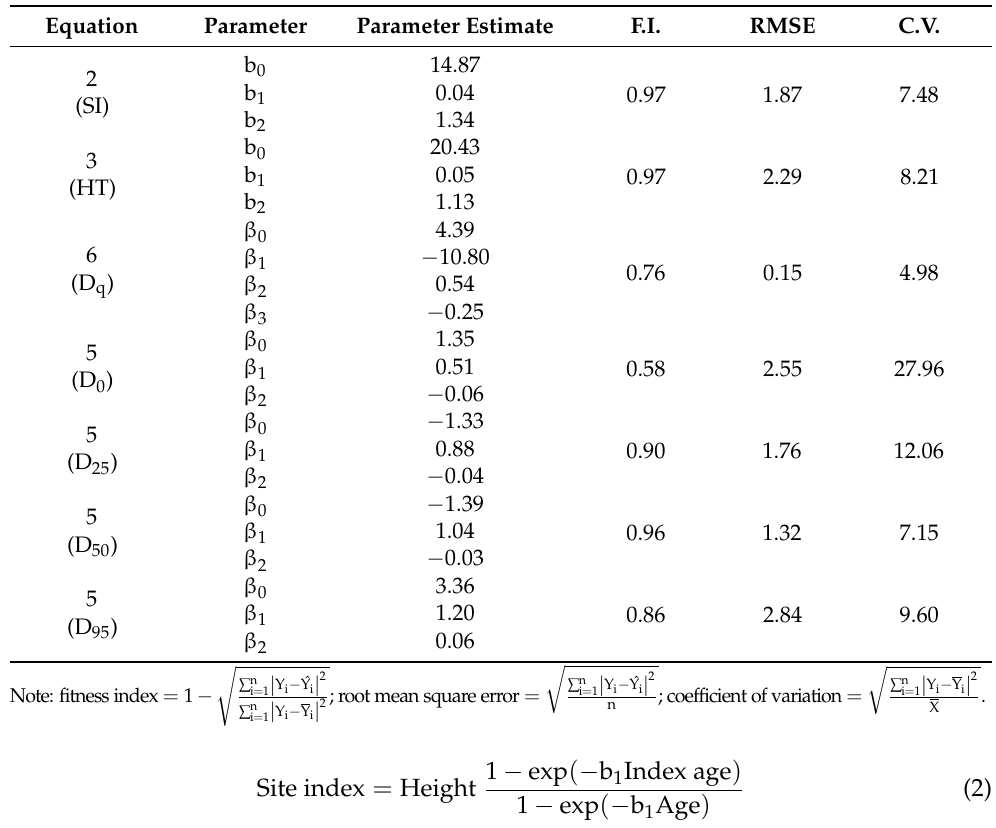
Table 2. Parameter estimates and fit statistics for site index (SI), individual tree height (HT), quadratic mean diameter (Dq), and percentiles of the diameter distribution (D 0 , D 25 , D 50 , and D 95 ) models. Equation Parameter Parameter